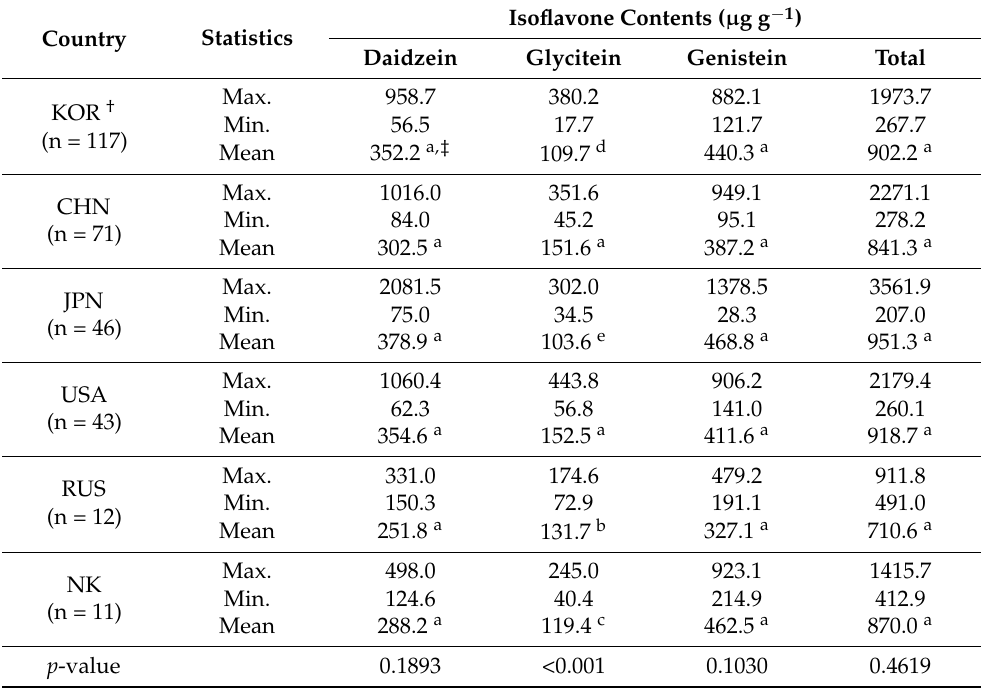
Table 5. Maximum, minimum and mean value of isoflavone contents according to collected countries in 300 soybean germplasms.